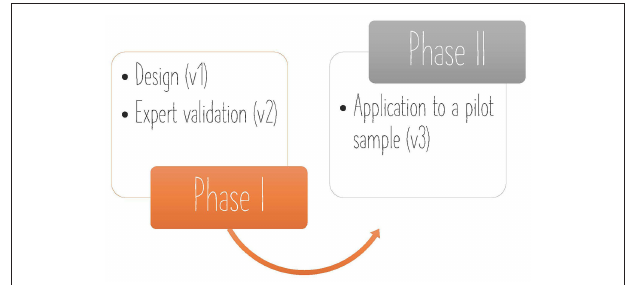
FIGURE 2 | Phase I and phase II stages, and questionnaire versions obtained in each one of